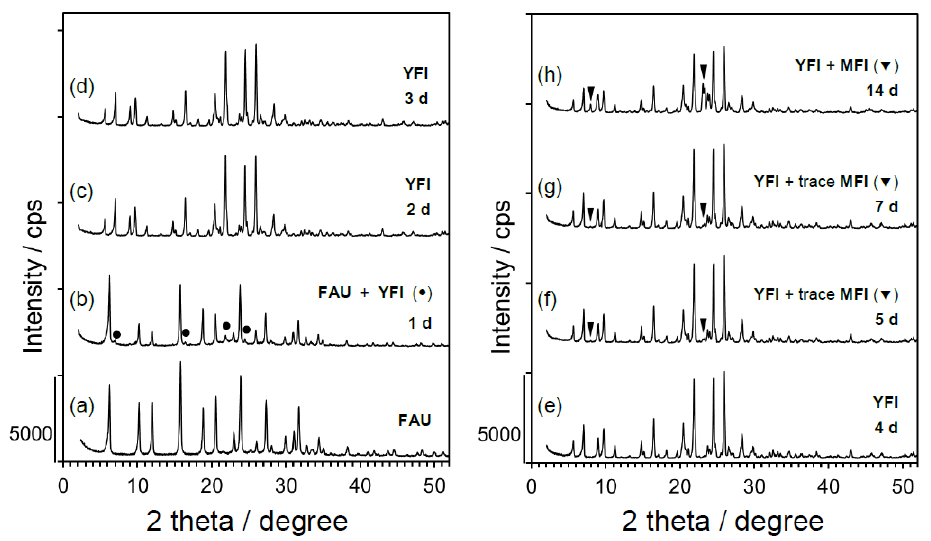
Figure 3. Phase changes over time as reflected in the powder X-ray diffraction patterns of (a) the starting material ( FAU ) and (b–h) as-synthesized samples crystallized under static conditions at 160 ◦ C. The starting molar composition was 0.265SiO 2 (from FAU ) – 0.735SiO 2 (from colloidal silica) – 0.025Al 2 O 3 (from FAU ) – 0.17Me 2 Pr 2 N + OH − – 0.15NaOH – 0.15KOH – 7.0H 2 O. The FAU was HSZ-350HUA (Lot #35UA3Y02).